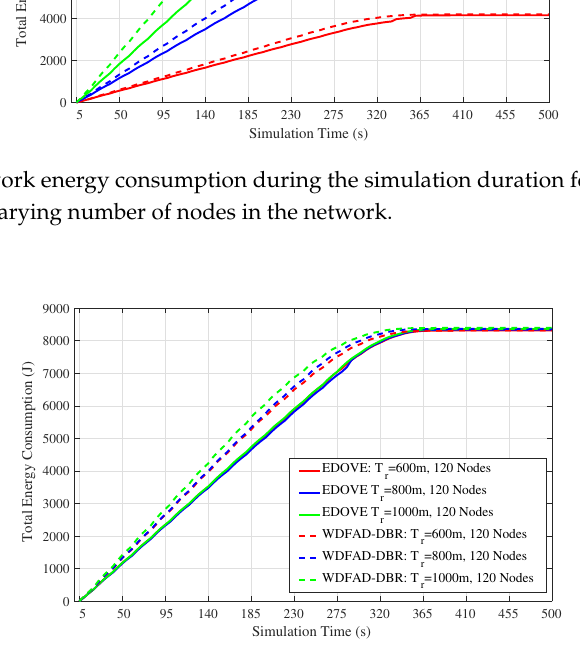
Figure 11. Total network energy consumption during simulation duration for the fixed number of nodes (120 nodes) and different transmission ranges in the